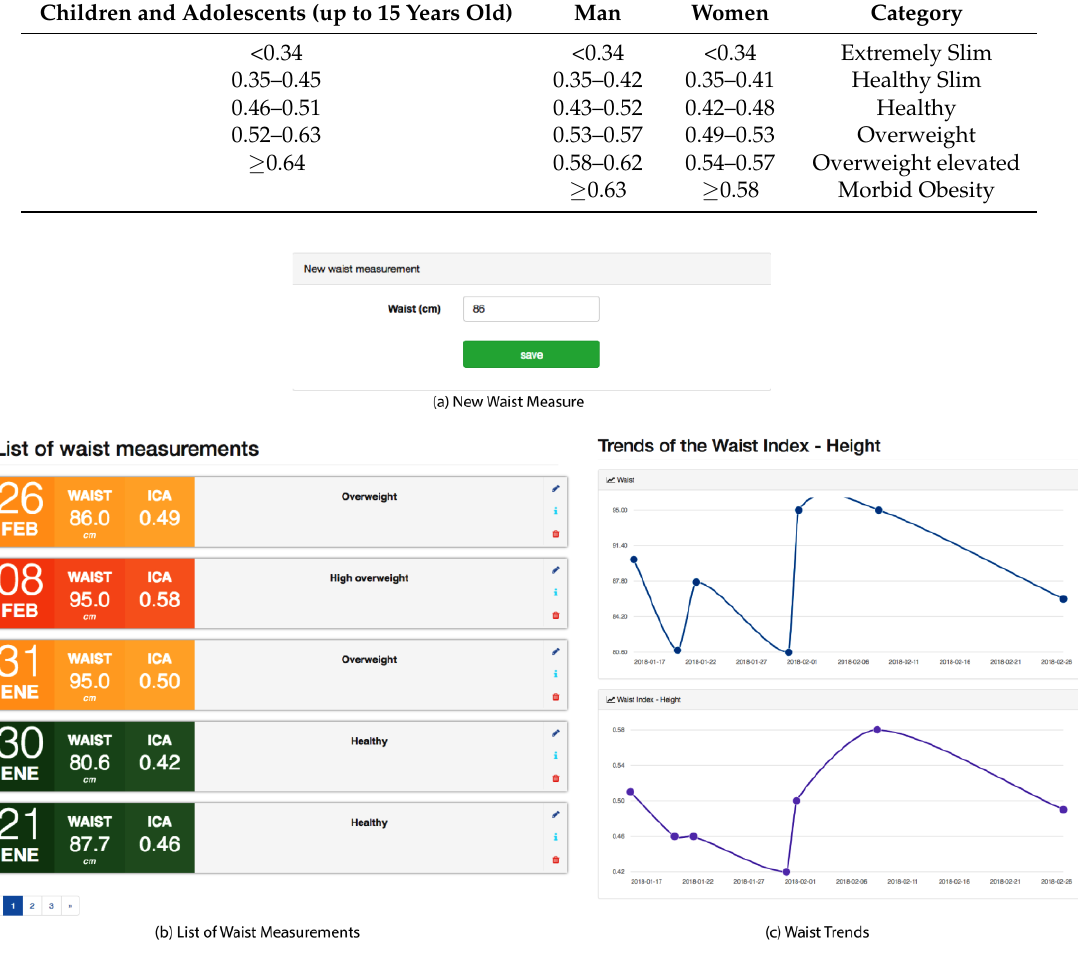
Figure 8. Waist-to-Height Ratio module.